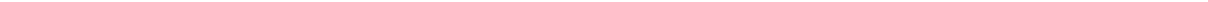
Fig. 2 Inhibition of dorsolateral pons by vlPAG GABAergic projection suppresses REM sleep and wakefulness while promoting NREM sleep. a Left, schematic depicting ChR2-mediated activation of GABAergic axons projecting from vlPAG to the dorsolateral pons. Right, coronal diagram of mouse brain (top) and fl uorescence image (bottom) of dorsolateral pons (black box in diagram) in a GAD2 - Cre mouse injected with AAV expressing ChR2 – eYFP (green) into the vlPAG. Blue bar, optic fi ber. Blue, DAPI. Scale bar, 500 μ m. DTg dorsal tegmental nucleus, scp superior cerebellar peduncle. b Top, normalized EEG spectrogram. Bottom, percentage of REM, NREM, or wake states before, during, and after laser stimulation of GABAergic axons ( n = 5). Shading, 95% CI. c Schematic showing rabies-mediated trans-synaptic tracing. TC 66T mutant EnvA receptor fused with mCherry, RG rabies glycoprotein, RV dG RG-deleted rabies virus. d Top, fl uorescence image of SLD in VGLUT2-Cre mouse. Scale bar, 200 μ m. Bottom, enlarged view of white box showing starter cells (yellow, arrowheads), expressing both eGFP and mCherry. Scale bar, 20 μ m. e Top, fl uorescence image of LDT in ChAT - Cre mouse. Scale bar, 200 μ m. Bottom, enlarged view of white box showing starter cells (yellow, arrowheads). Scale bar, 20 μ m. f Top, fl uorescence image of LC in TH-Cre mouse. Scale bar, 200 μ m. Bottom, enlarged view of white box showing starter cells (yellow, arrowheads). Scale bar, 20 μ m. g Coronal diagram of mouse brain. Aq aqueduct. h vlPAG GABAergic ( GAD2 ) neurons innervating glutamatergic ( VGLUT2 ) SLD neurons. Top, fl uorescence image showing rabies- eGFP-labeled (green) and GAD2 -positive neurons in vlPAG ( n = 3 mice). Red, GAD2 . Blue, DAPI. Scale bar, 200 μ m. Bottom, enlarged view of white box showing eGFP-labeled neurons expressing GAD2 (arrowheads). Scale bar, 30 μ m. i Similar to h , for vlPAG GABAergic neurons innervating cholinergic ( ChAT ) LDT neurons ( n = 3). j Similar to h , for vlPAG GABAergic neurons innervating noradrenergic ( TH ) LC neurons ( n = 3). k Percentages of rabies- eGFP-labeled neurons in vlPAG innervating glutamatergic SLD neurons, cholinergic LDT neurons, and noradrenergic LC neurons ( n = 3). Circles, single mice; error bars, ± s.d. Brain fi gures in a , c , g were adapted from Allen Mouse Brain Atlas (© 2015 Allen Institute for Brain Science. Allen Brain Atlas API. Available from: